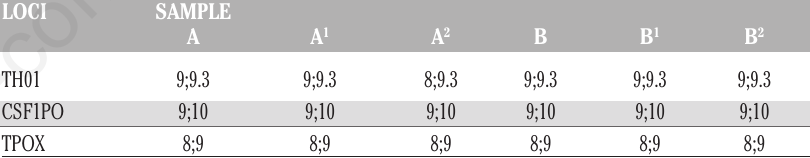
Table 2. Allele STR CODIS's profile.